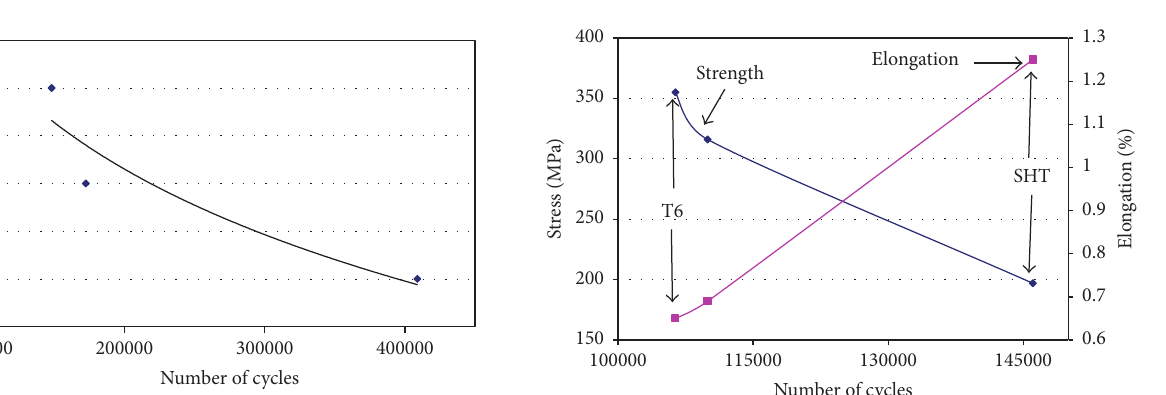
Figure 11: Stress-number of cycles (S-N) curve for DCM0